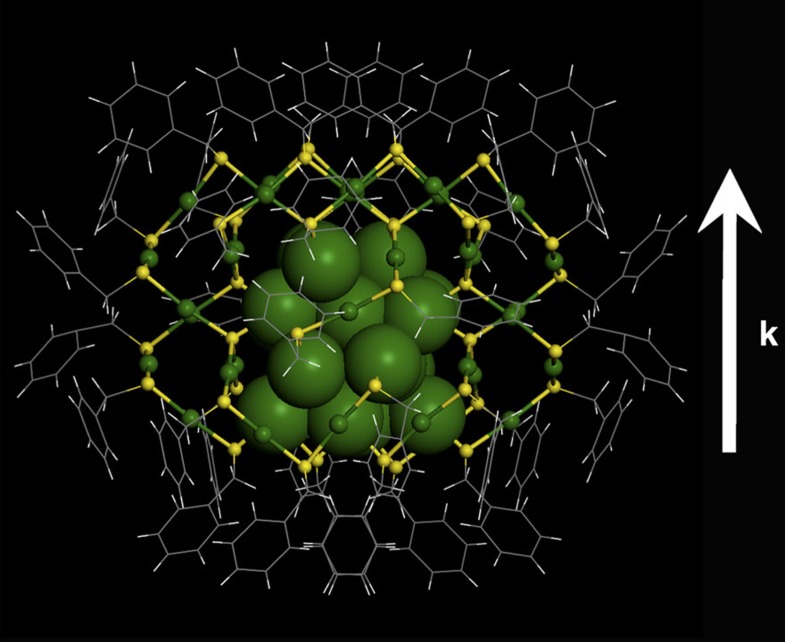
X-ray atomic structure of the Au60S6(SCH2Ph)36 nanocluster.The Au atoms are in green, the sulfur atoms are in yellow, and the benzyls are in wireframe. The vertical upward arrow indicates the direction of the k-vector.